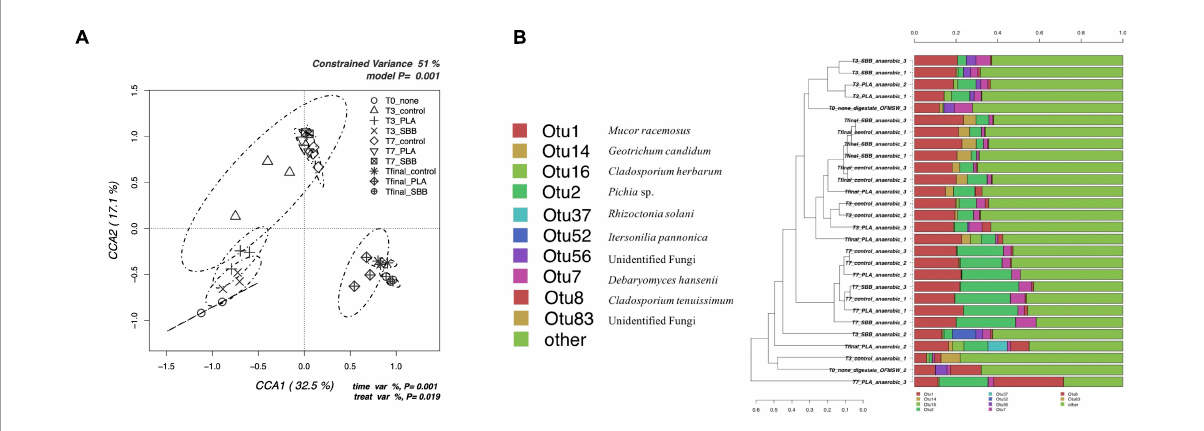
FIGURE6 Fungal community during anaerobic digestion. (A) Hypothesis-driven canonical correspondence analysis (CCA) model performed on the total bacterial OTUs relative abundance data from anaerobic digestion intermediate samples. (B) Overview and identification of the most abundant OTUs comprising 95% of the fungal diversity in anaerobic digestion intermediate samples. PLA, polylactic acid; SBB, starch-based bioplastic; OFMSW, organic fraction of municipal solid